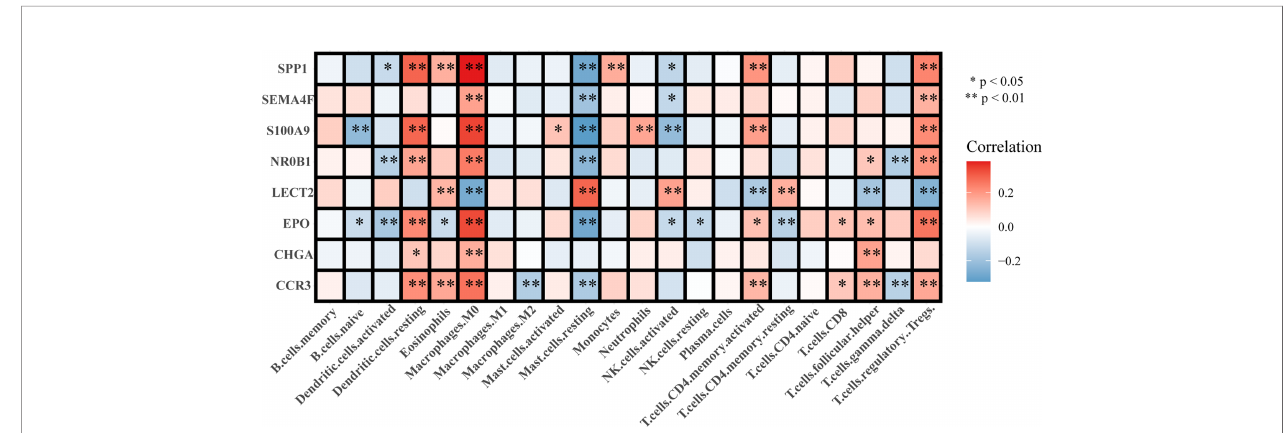
FIGURE 7 | Correlation between the signature genes and immune cell in fi